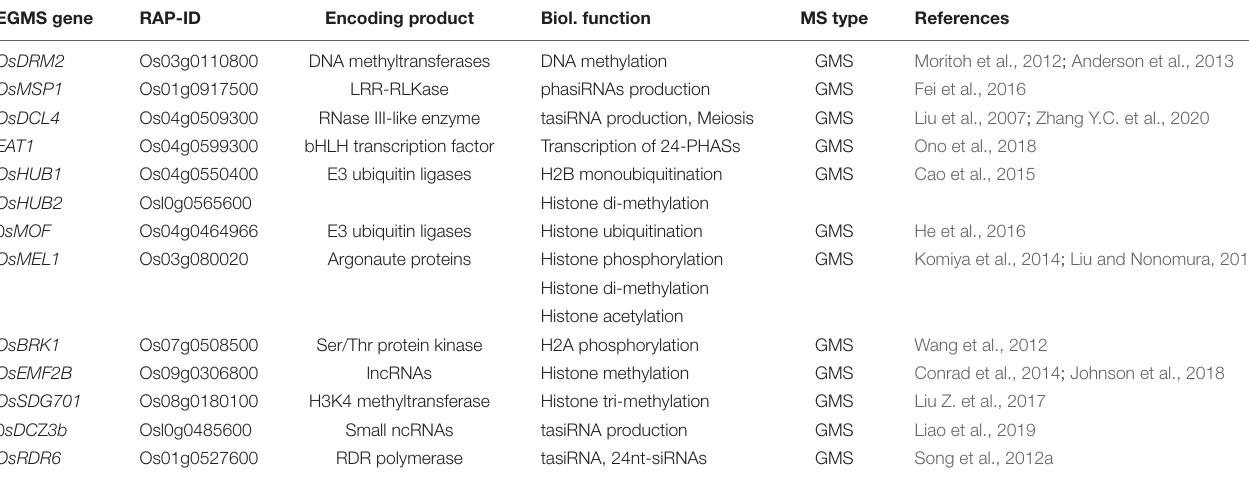
TABLE 3 | List of characterized genes for epigenetic regulation of genic male sterility (GMS) in